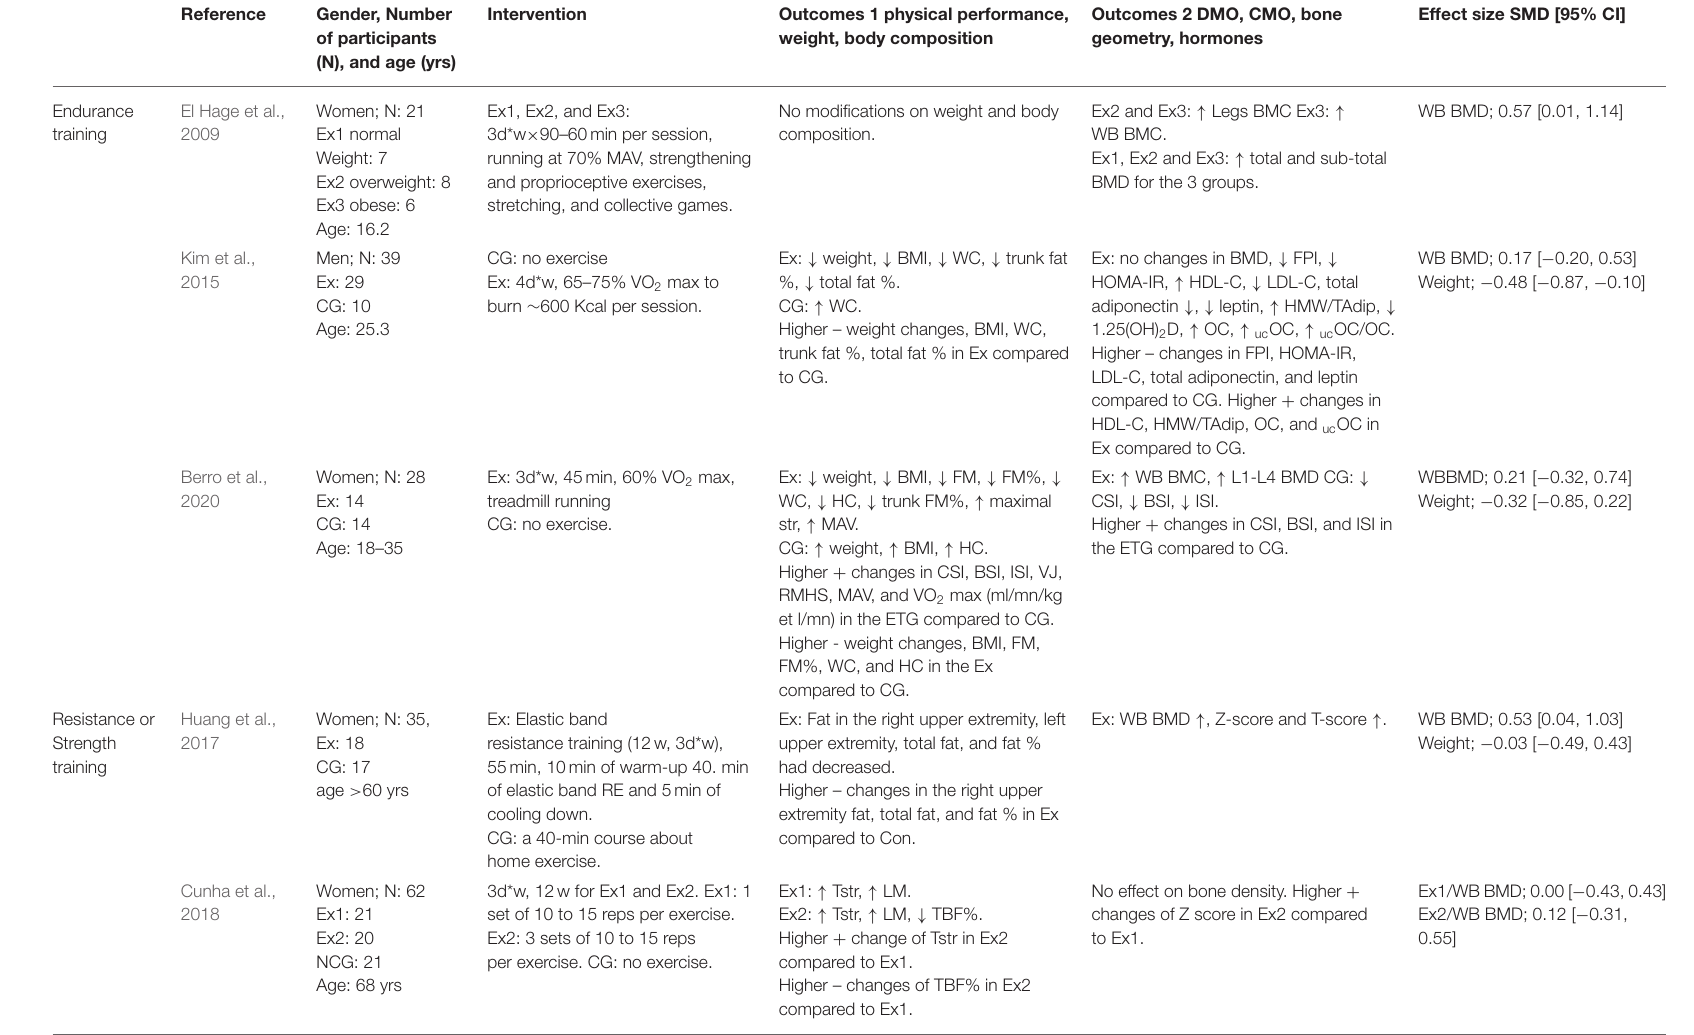
Effect size SMD [95% CI]